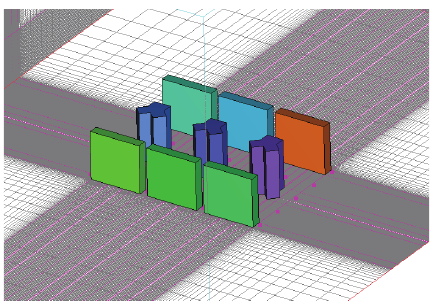
Figure 4: CFD modeling (model